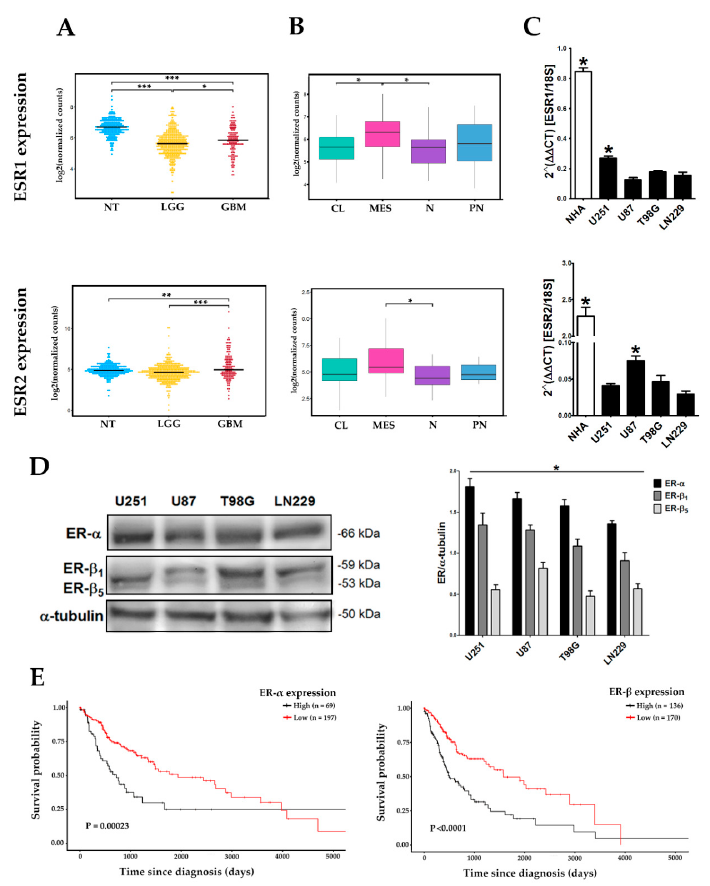
Figure 1. The estrogen receptor- α (ER- α ) and estrogen receptor- β (ER- β ) subtype gene expressions in human glioblastoma multiforme (GBM). ( A ) Ribonucleic acid sequencing (RNA-Seq) counts obtained from low-grade gliomas (LGG, n = 167) and GBM ( n = 155) projects from The Cancer Genome Atlas (TCGA) and expression profiles obtained from healthy brain cortex samples (normal tissue, NT; n = 249) in the GTEx database. LGG includes grade I, II, and III gliomas. * p < 0.05; ** p < 0.01; *** p < 0.001. ( B ) RNA-Seq counts from GBM subtypes: classical (CL), mesenchymal (MES), neural (N), and proneural (PN) obtained from TCGA. * p < 0.05. ( C ) RT-qPCR quantified gene expression of estrogen receptor 1 / α (ESR1) and estrogen receptor 2 / β (ESR2) relative to the reference gene 18S ribosomal RNA (rRNA) using the comparative 2 ∆∆ Ct method in total RNA from normal human astrocyte (NHA) and U251, U87, T98G, and LN229 human GBM-derived cells. Both receptor subtypes were less expressed in GBM cells than in NHAs. * p < 0.05 vs. all other groups; mean ± standard error of the mean (SEM), n = 3. ( D ) ER- α and ER- β content analyzed by Western blot using α -tubulin as load control. The two main isoforms of ER- β expressed in GBM are shown: ER- β 1 and ER- β 5. Representative blot image and the corresponding densitometric analysis for ER α and ER β expression in human GBM-derived cells. * p < 0.05 ER- α vs. ER- β and ER- β 1 vs. ER- β 5; mean ± SEM, n = 3. ( E ) Survival analysis for ER- α and ER- β expression in GBM using TCGA